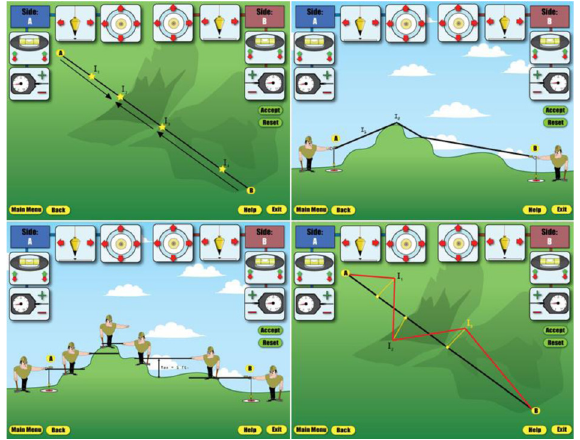
Figure 3. Screenshots of the current application illustrating the limitations of the 2D environment. Clockwise from top left: top view of the terrain with temporary points; cross-section view of the terrain; alignment of temporary points with end points; cross-section of terrain with breaking down the chain